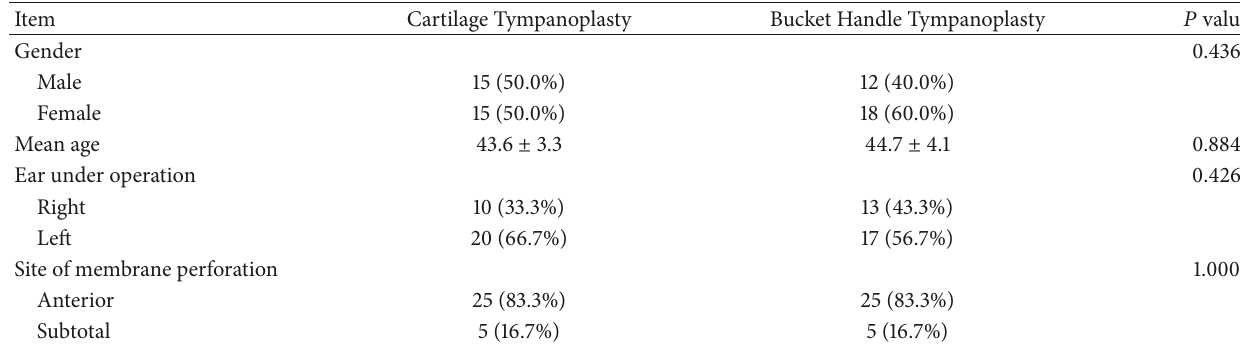
Table 1: Baseline characteristics of study population.